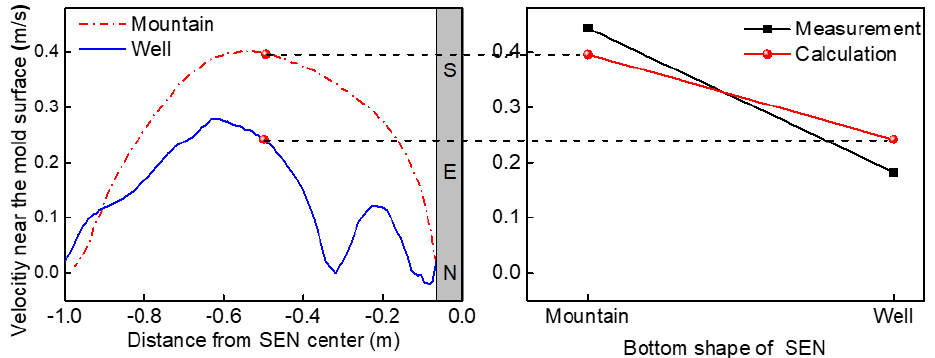
Figure 12. Comparison of the measured and calculated velocities near the mold surface with dif- ferent bottom shapes of SEN.